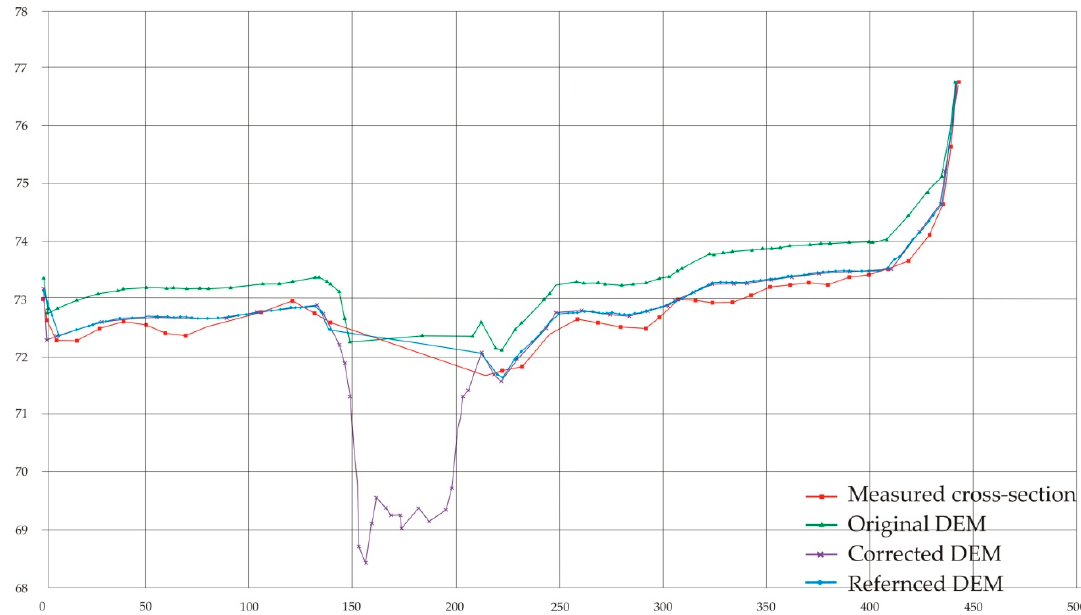
Figure 8. Comparison of the measured elevation at a selected cross-section with elevation points derived from the original, corrected and referenced DEMs.